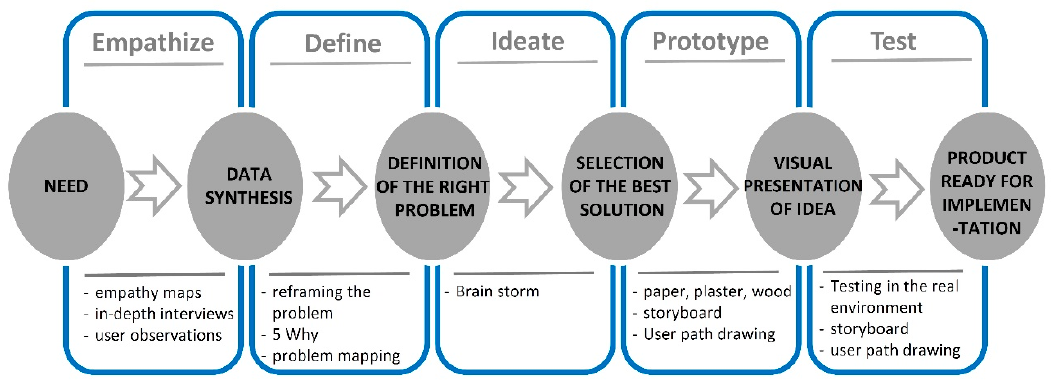
Figure 4. Overview of the Design Thinking methodology, adapted from [19–21].